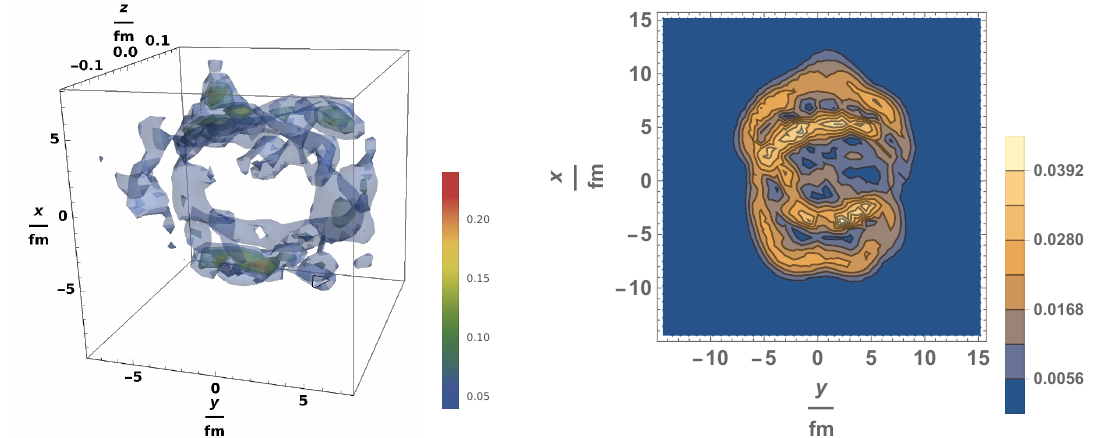
Figure 10 . On the left: the absolute value of the vorticity three vector ~ω at t = 0 . 1 fm /c , the spatial coordinates on the axes are given in units of [fm]. On the right we show the vorticity at t = 0 . 1 fm /c at vanishing rapidity. The results are given in units of [ GeV ] . Most of the initial (geometric) angular momentum is deposited far away from the central region where the hydrodynamized quark gluon plasma is